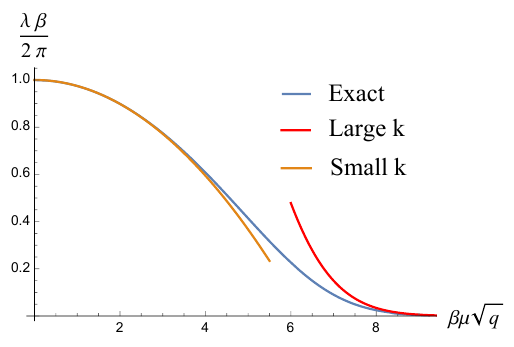
Figure 19 . Plot of Lyapunov exponent as a function of p q(cid:12)(cid:22) = p 2 k with exact, small k and large k